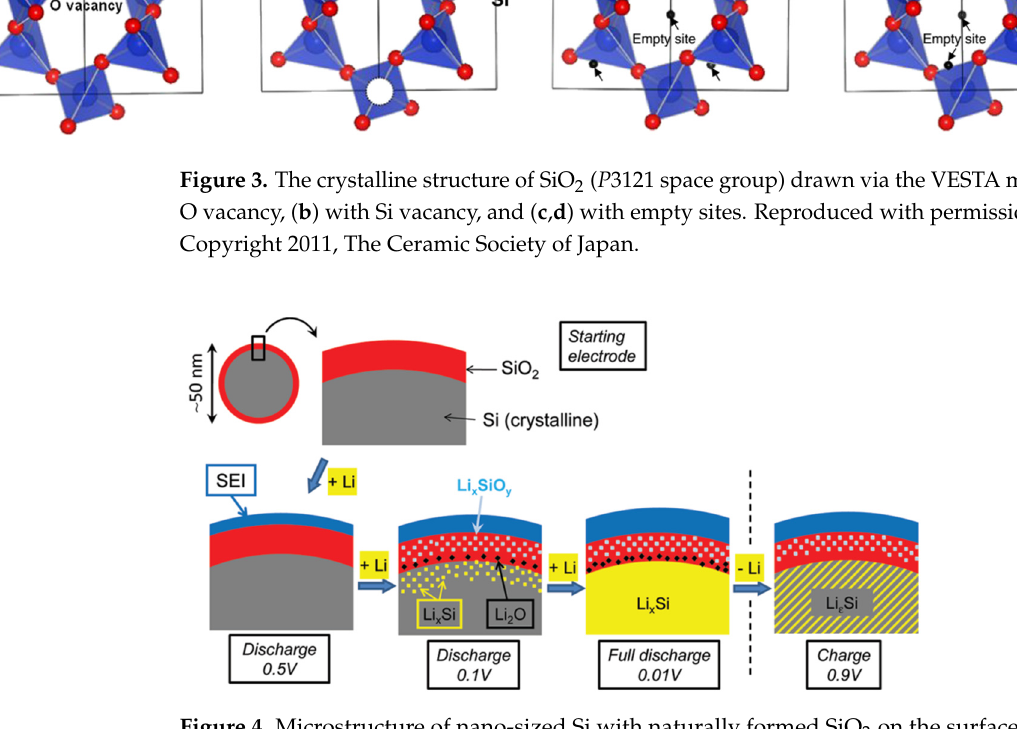
Figure 4. Microstructure of nano-sized Si with naturally formed SiO 2 on the surface. Composition changes during shallow and deep discharge and full recharge. Reproduced with permission from ref. [23]. Copyright 2012, ACS Publications.